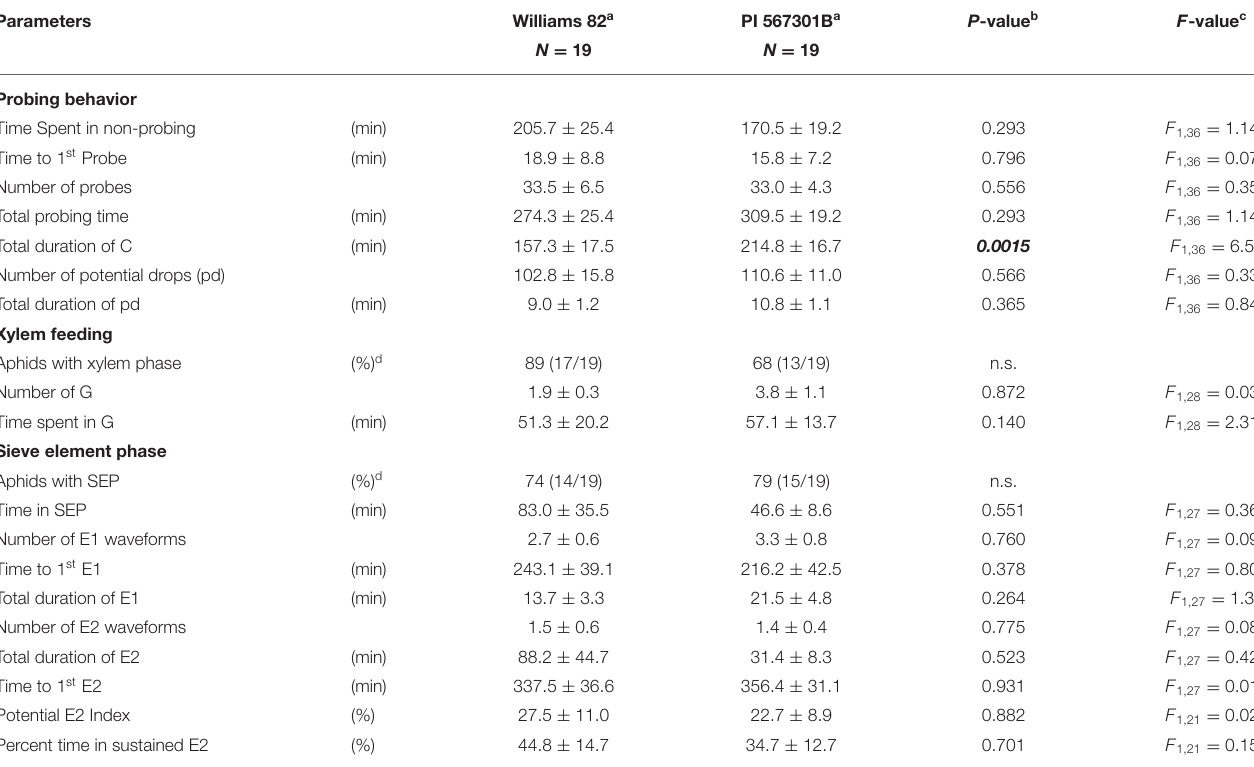
TABLE 2 | Feeding behaviors of aphids on whole plants of Williams 82 and PI 567301B.